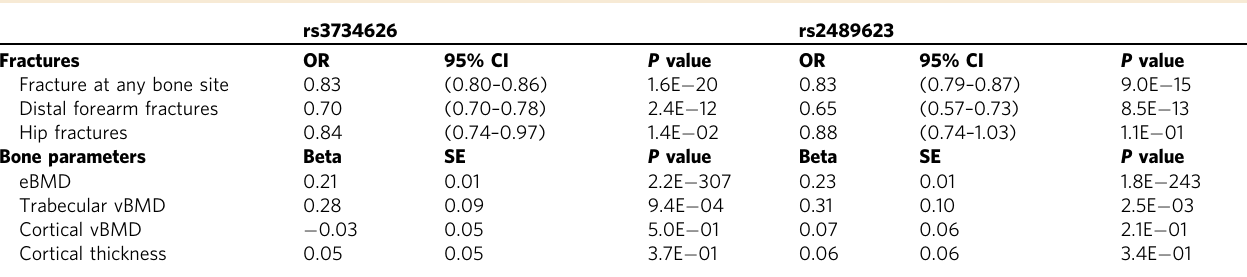
Table 2 Mendelian randomization studies of the estimated causal associations of circulating RSPO3 level on fractures and bone